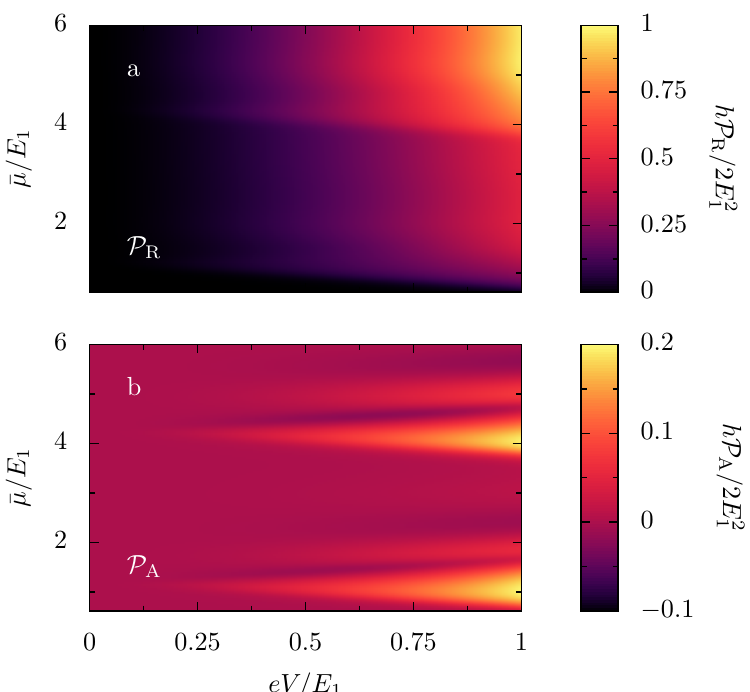
Figure 3: Colorscale plot of the dissipated power on the right difference (panel b), as a function of the applied voltage and the mean electro- P A chemical potential, at zero